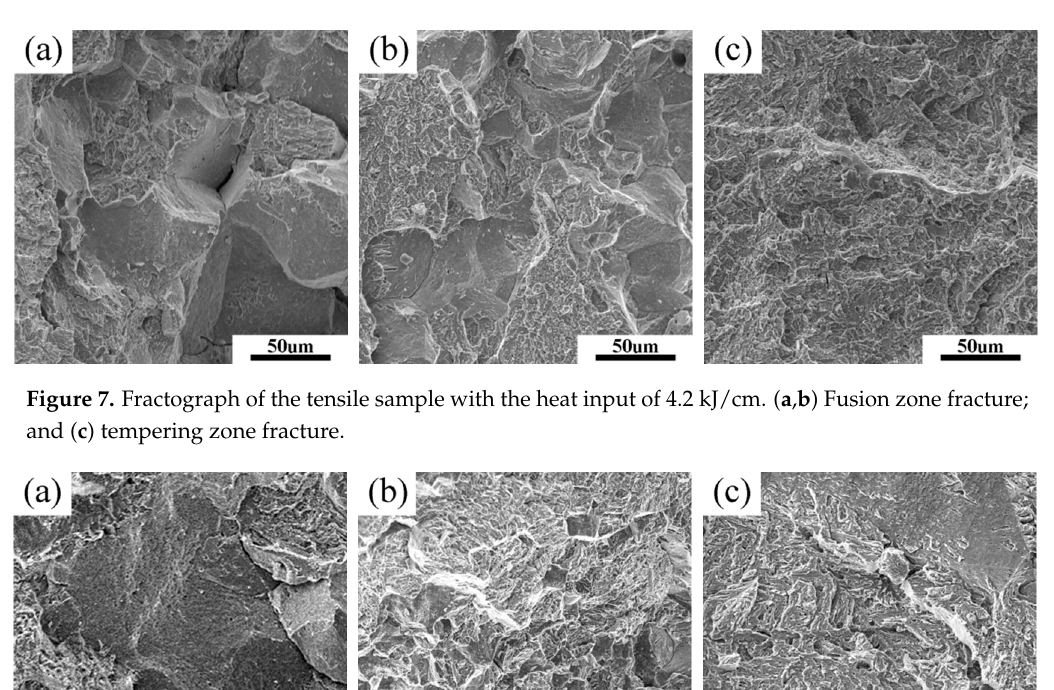
Figure 6. Stress-strain curve of weld joints. ( a ) Samples A; ( b ) Samples B; and ( c ) Samples C.